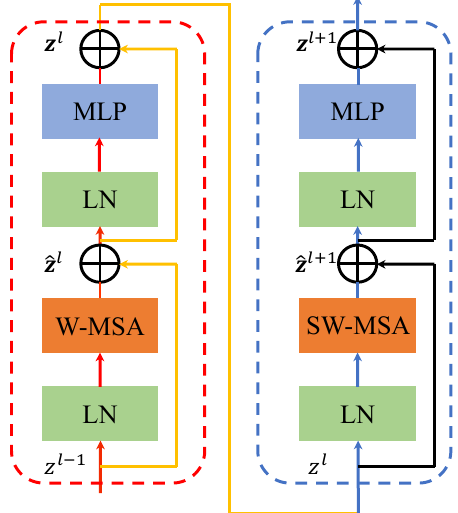
Figure 5. Two successive Swin transformer blocks.